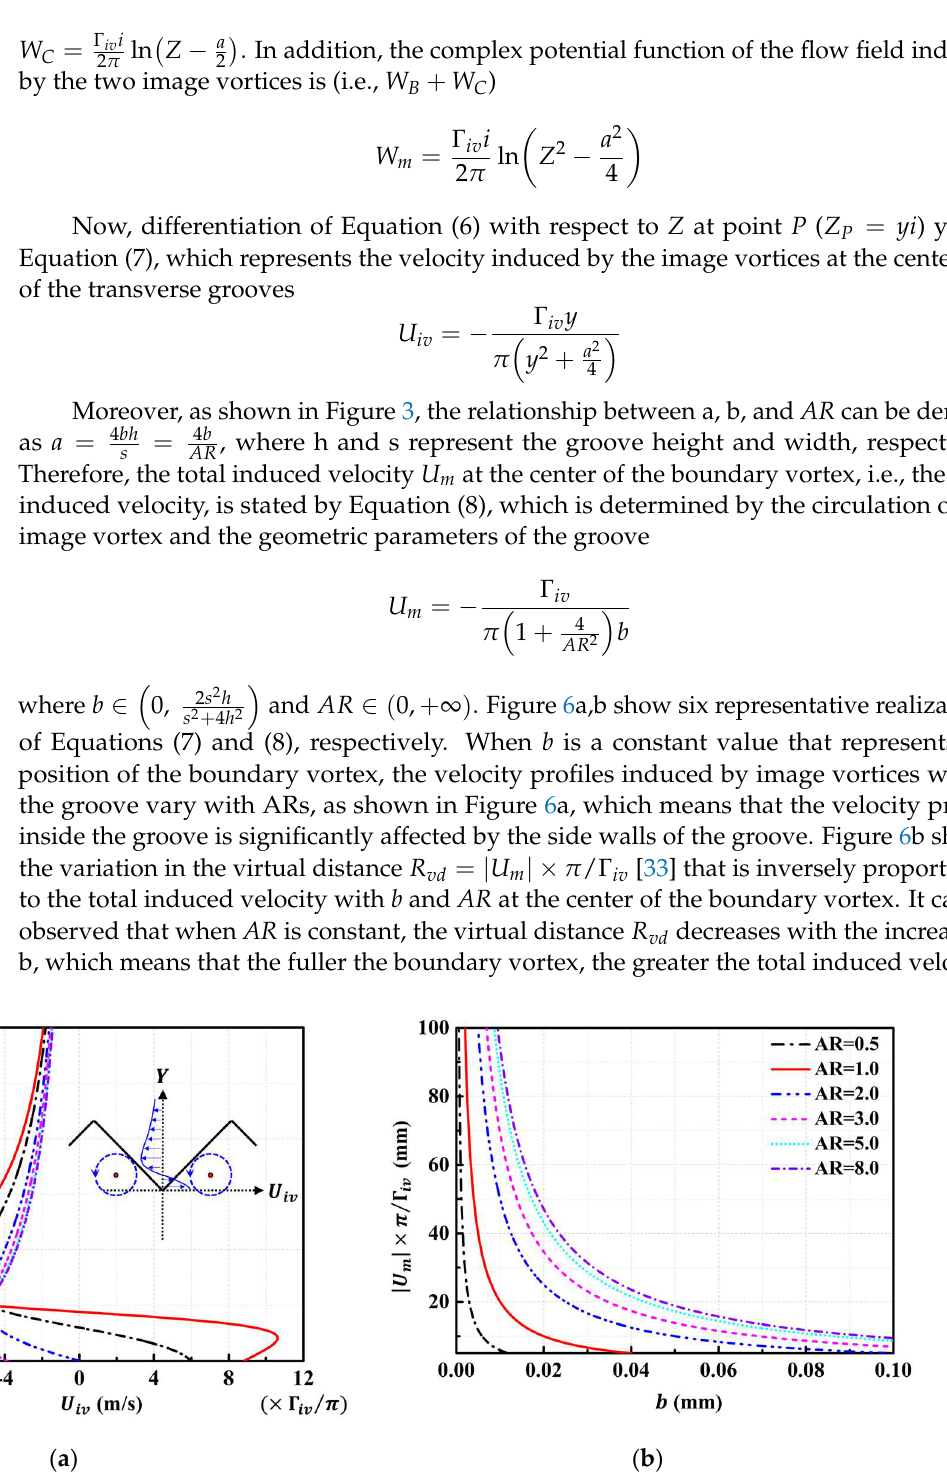
is a constant representing the total induced ve- Q (cid:2) 9U